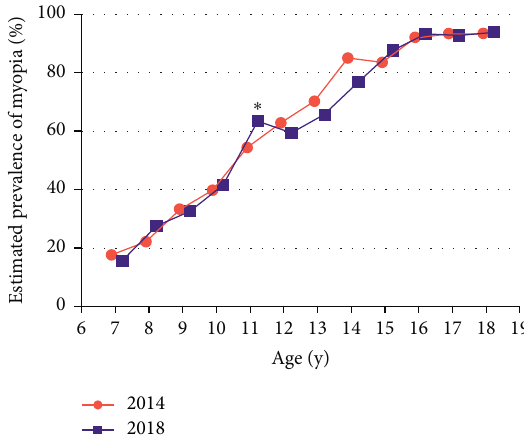
Figure 2: Trends of prevalence of myopia in children from 7- to 18- year-olds in 2014 and